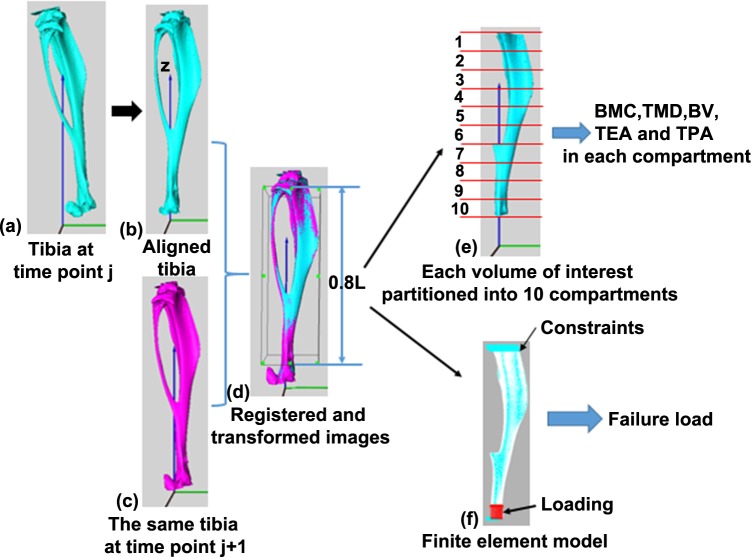
Schematic representation of the calculation of the structural, densitometric and mechanical properties of the tibia.(a-d) Rigid registration of the mouse tibiae using a stepwise approach; (e) quantification of the structural (BV, TEA and TPA) and densitometric (BMC and TMD) properties of the tibia; (f) calculation of the mechanical (failure load) properties of the tibia.